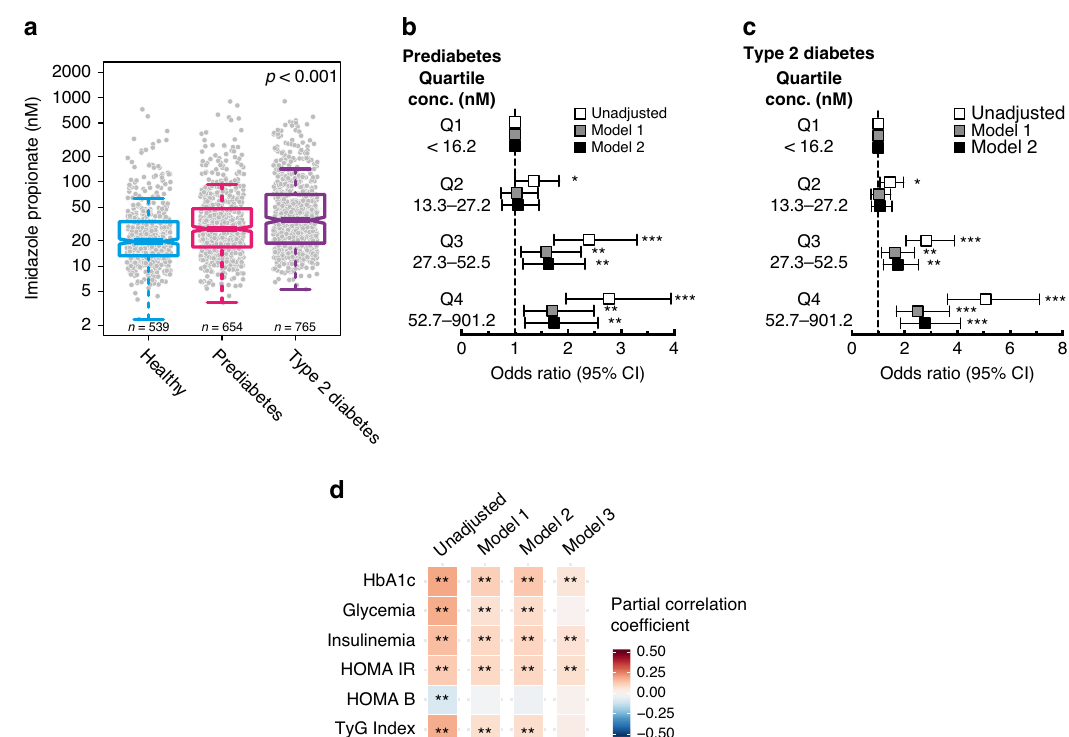
Fig. 1 Imidazole propionate is increased in subjects with type 2 diabetes. a Serum levels of imidazole propionate in healthy subjects ( n = 539), subjects with prediabetes ( n = 654), and with type 2 diabetes ( n = 765). P -values were calculated with linear regression. Data are represented as boxplots: middle line is the median, the lower and upper hinges are the fi rst and third quartiles, the upper whisker extends from the hinge to the largest value no further than 1.5× the interquartile range (IQR) from the hinge, and the lower whisker extends from the hinge to the smallest value at most 1.5× IQR of the hinge. Gray dots are single data points. b , c . Multinomial logistic regression for prediabetes and type 2 diabetes vs. healthy controls according to imidazole propionate quartiles. Odds ratios (OR) were calculated using the lowest quartile of imidazole propionate (Q1) as reference. Model 1 OR was adjusted for age, gender, body mass index (BMI), and ethnicity. Model 2 OR was adjusted for model 1 plus creatinine clearance. Squares represent OR and the upper and lower whisker the 95% con fi dence intervals (CI), raw data are presented in Supplementary Table 1. * P < 0.05, ** P < 0.01, *** P < 0.001 d . Correlation matrix for imidazole propionate and glycated hemoglobin (HbA1c), glycemia, insulinemia, homeostatic model assessment of insulin resistance (HOMA-IR), updated HOMA model for beta-cell function (HOMA-B), and the triglyceride and glucose (TyG) index. Pearson partial correlation coef fi cients and P -values were calculated using partial correlations adjusted for Model 1: age, gender, body mass index, and ethnicity. Model 2: Model 1 plus creatinine clearance, Model 3: Model 2 plus diabetes status. False discovery rate (FDR) adjusted * P < 0.05, ** P < 0.01. See also Supplementary Table 2. Source data are provided as a Source Data fi